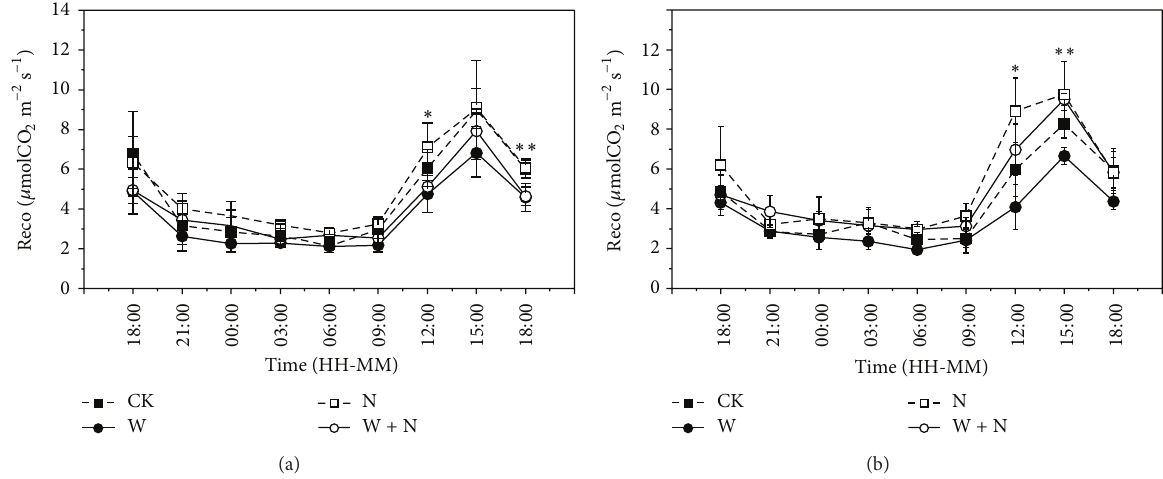
Figure 2: Diurnal variations of soil respiration under different treatments in alpine meadow measured on July 22 ∼ 23 (a) and August 21 ∼ 22 (b), 2012. CK, control (solid square with dot line); N, N addition (open triangle with dot line); W, warming (solid square with straight line); W + N, warming plus N addition (open triangle with straight line). Values represent the mean ± SE ( 𝑛 = 4